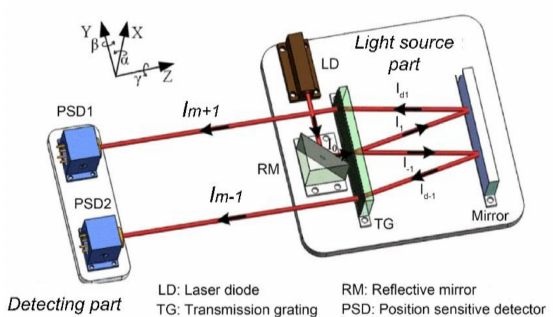
Figure 12. Roll angle measurement system using TG to produce parallel beams.